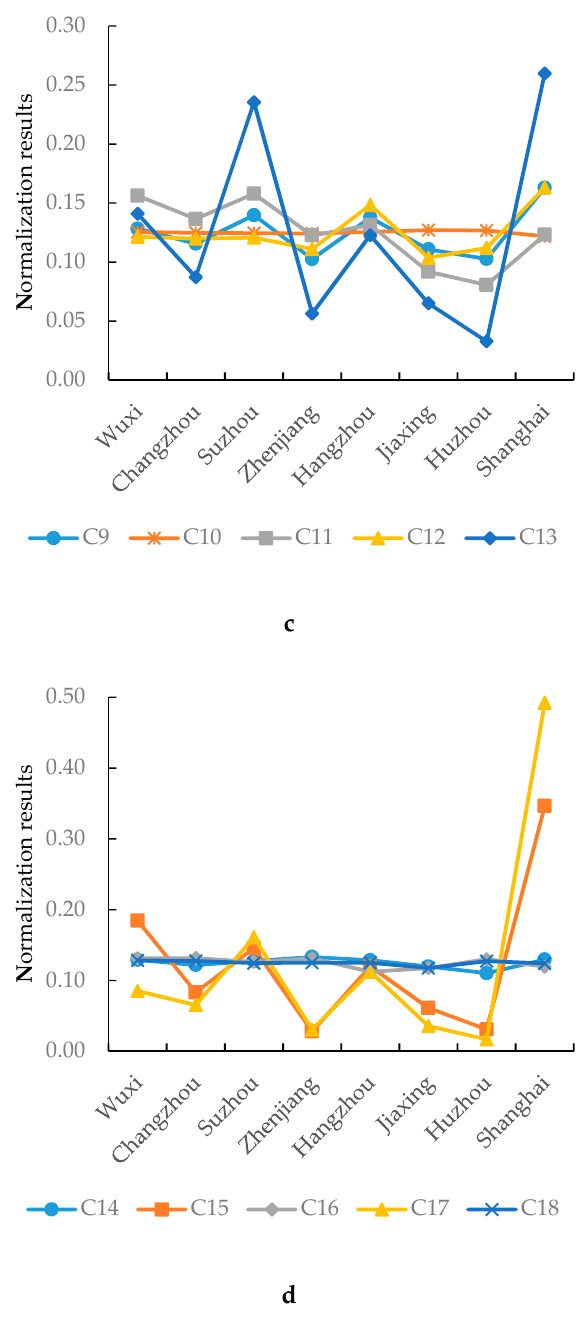
Figure 4. Normalization results of indexes in each region; ( a ) Natural condition; ( b ) Social development level; ( c ) Economic development level; ( d ) Technology and management.